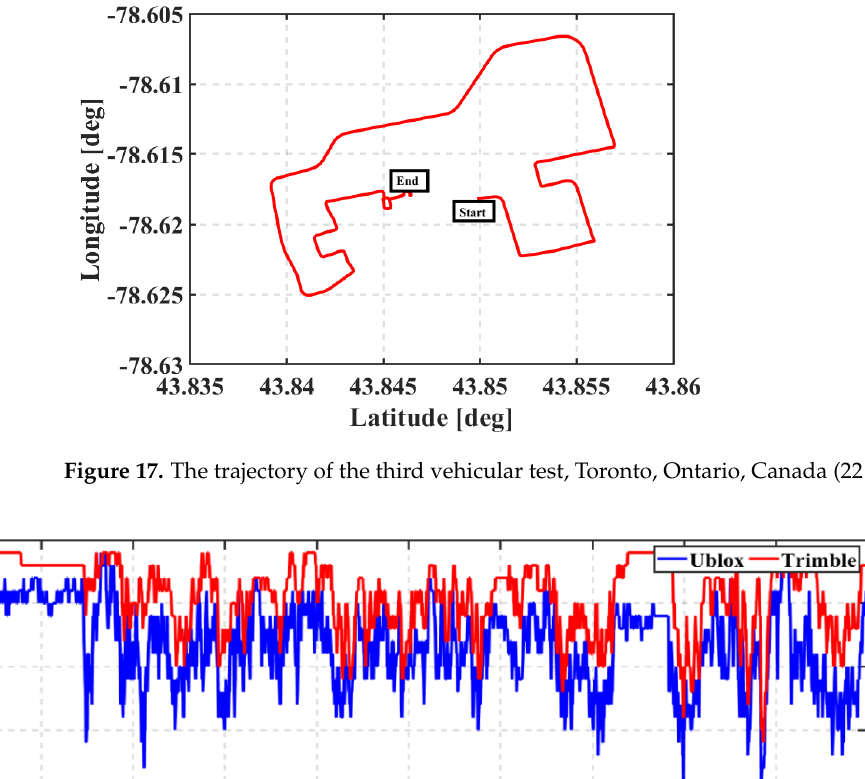
Figure 18. Third field trial: Number of tracked GPS, GLONASS, and Galileo satellites.